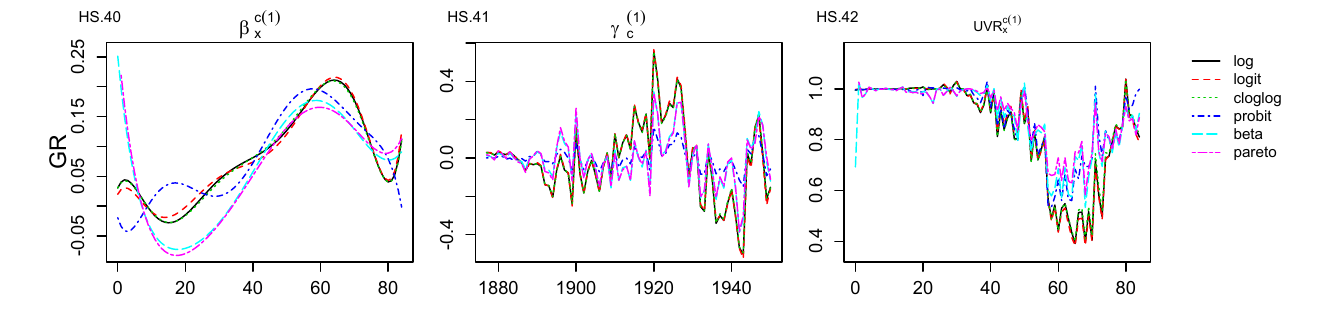
Figure A6. Age-cohort component for GR